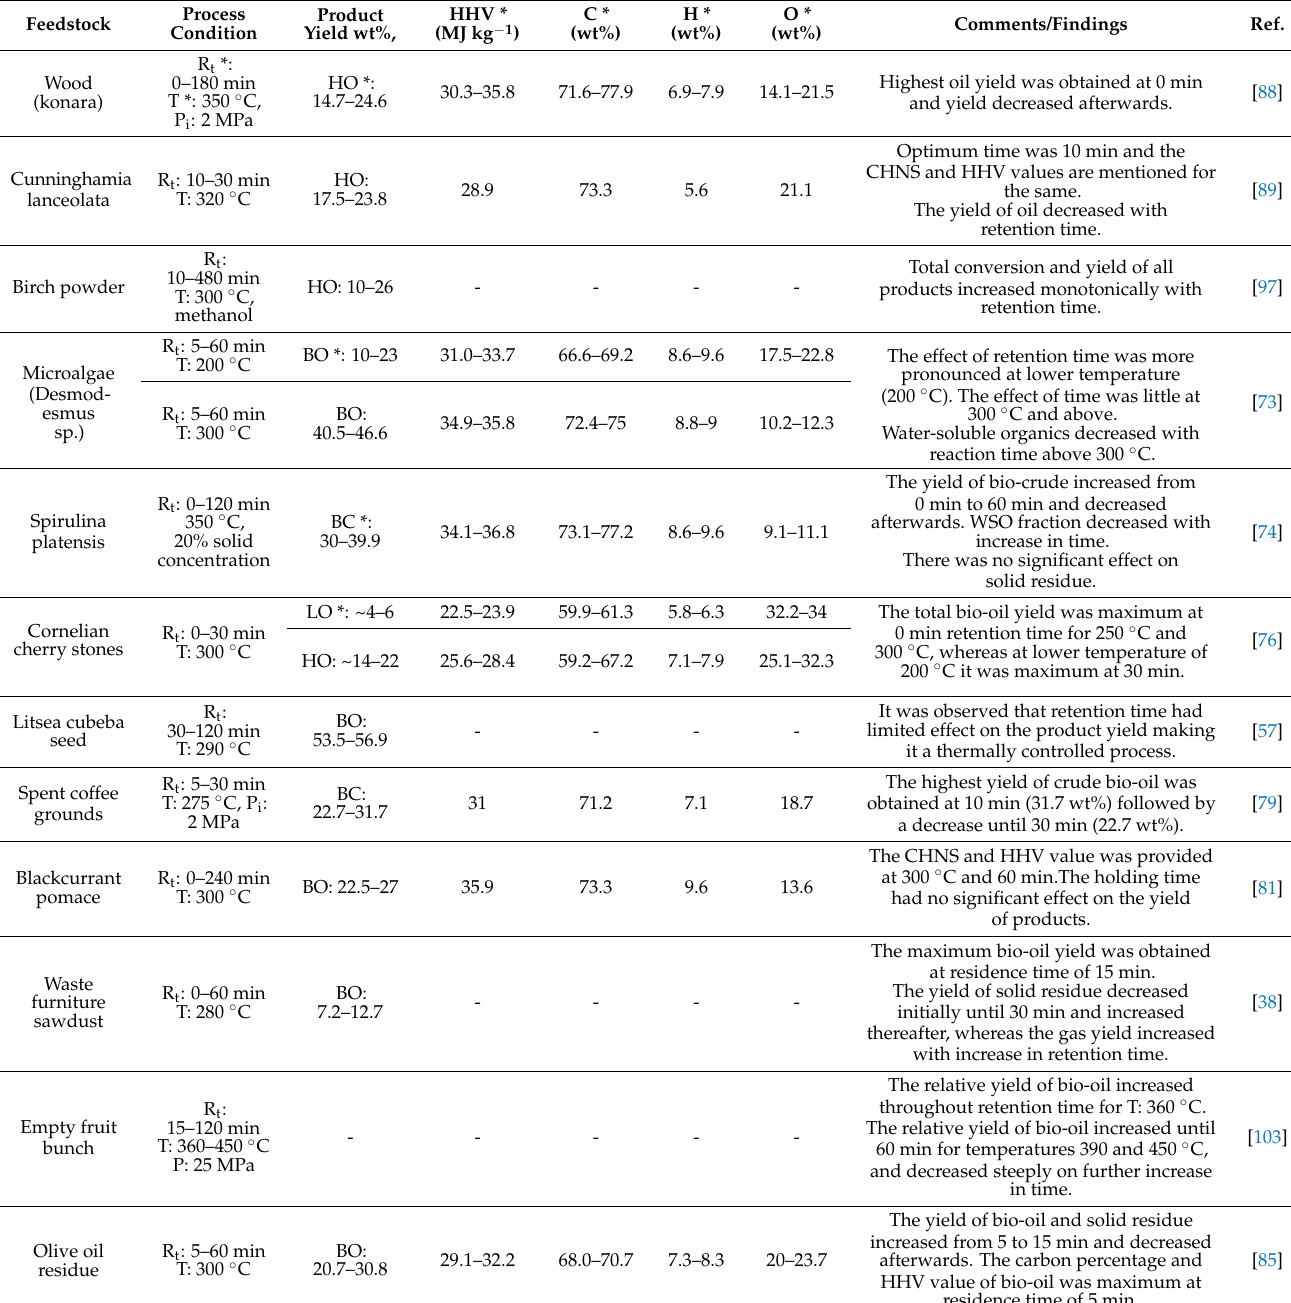
Table 5. Effect of retention time on HTL